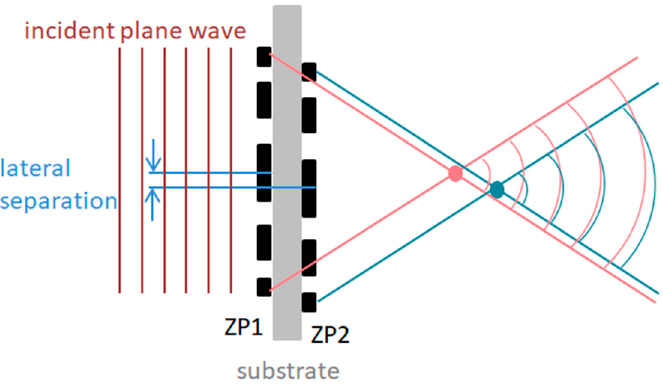
Figure 6. Sketch of the twin zone plates under Wilhein’s X-ray DIC microscope.